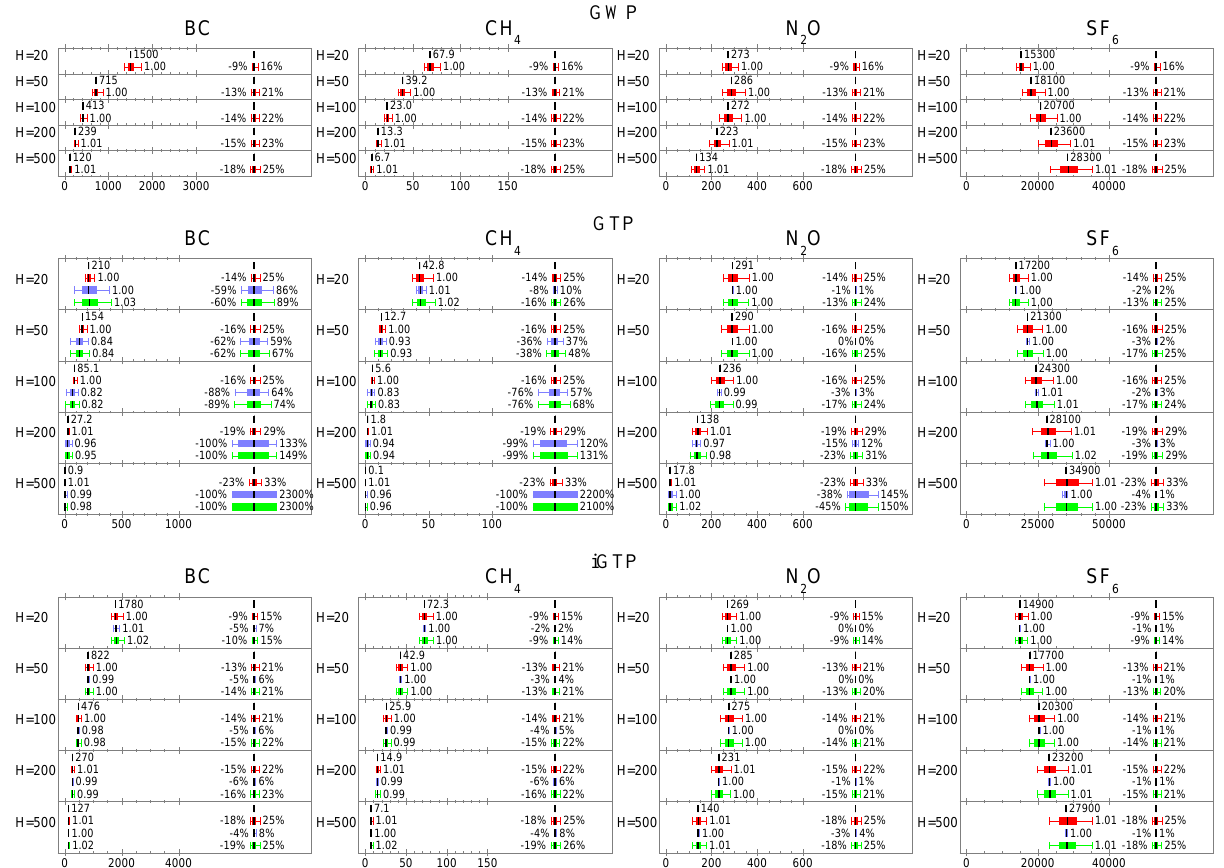
Fig. 6. Impact of variation in J13 IRF CO 2 and CMIP5 IRF T on GWP, GTP, and iGTP values for BC, CH 4 , N 2 O, and SF 6 for time horizons of 20, 50, 100, 200, and 500yr. The red bars give the impact of variation in IRF CO 2 , the blue bars the impact of variation in IRF T , and the green bars the impact of variation in both IRF CO 2 and IRF T . For every time horizon, the little black line (top) represents the reference value of the metric using the parameters as given in Tables 3 and 4 in the IRFs – the value itself is indicated to the right of the little line. The left bars give the 5-, 25-, 50-, 75-, and 95-percentile values of the metric (the 50-percentile value is indicated by a black line). The number right of the bar indicates how much the median value deviates from the reference value in relative terms. The right bars indicate the spread with respect to the median value, where again the 5-, 25-, 75-, and 95-percentile values are represented. The numbers (in %) left and right of the bars indicate how much the 5- and 95-percentile values deviate from the median value. The horizontal axis which gives the value of the metric is dimensionless.